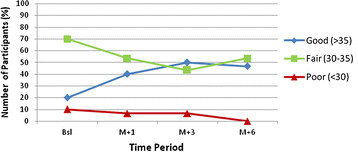
Distribution of CBIA-DM participants in attitude towards diabetes self-care.